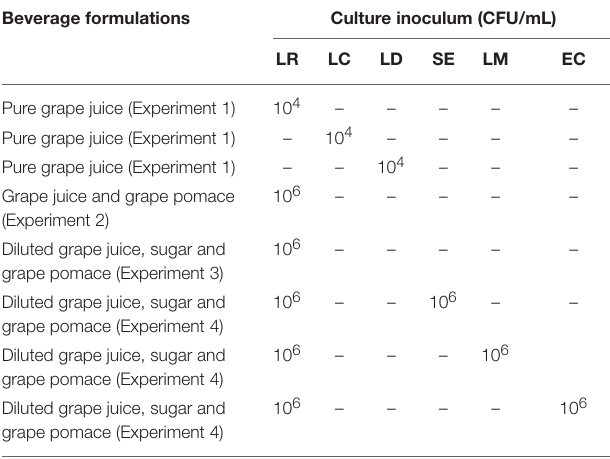
TABLE 1 | Lactic acid bacteria and pathogens inoculums concentration used on different beverage formulations. Beverage